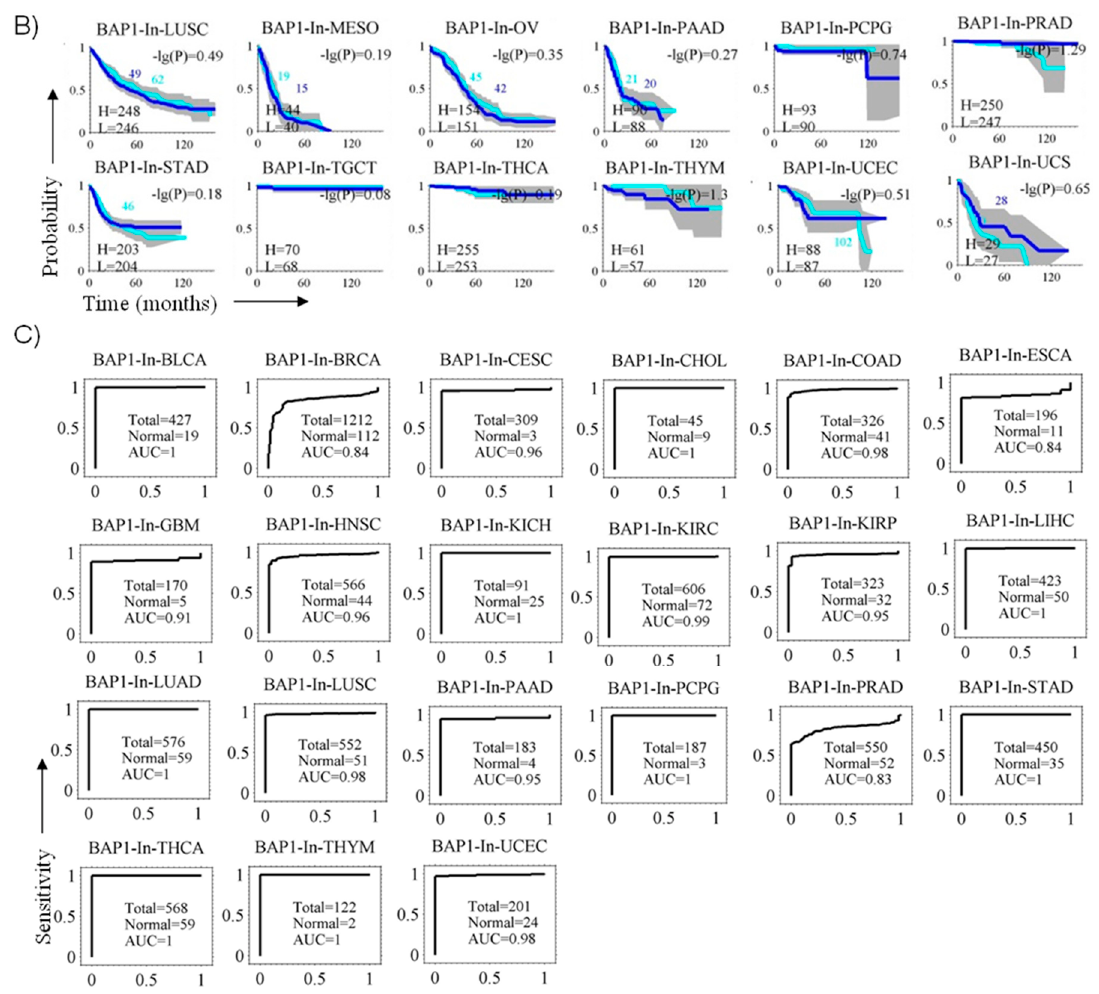
Figure 4. Estimation of the prognostic and diagnostic value in BAP1 gene expression in 29 cancer types (TCGA analysis). ( A ) Boxplots showing BAP1 gene expression in cancer ( C ) and in control (N) samples derived from the TCGA cohort. For each cancer type ( n = 29), the cancer samples are divided into high- (H) and low- (L) expression types. ( B ) The survival curves of the BAP1 gene in high- (H) and low- (L) expression from different cancer types (Blue: Low expression group; Sky blue: High expression group). ( C ) ROC curves reflect the good diagnosis ability of BAP1 in various cancers.